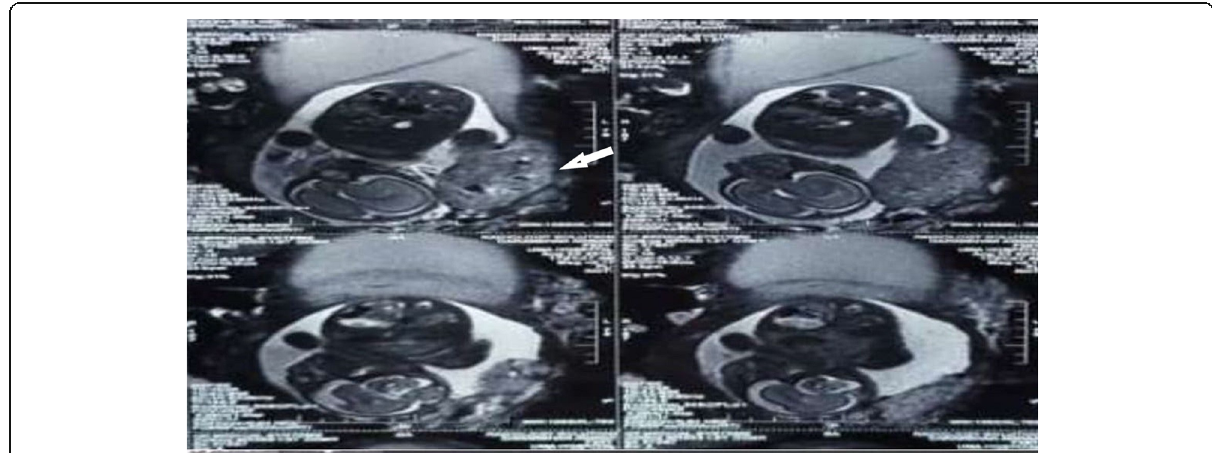
Fig. 1 MR image showing the placenta infiltrating the anterior lower uterine